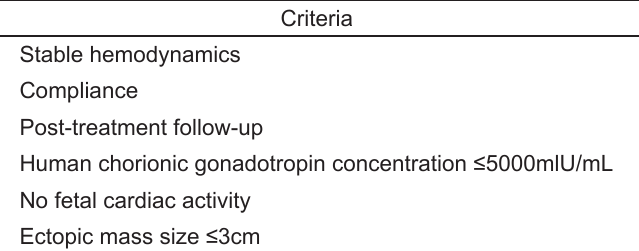
Table 1. Favorable criteria for medical management of ectopic